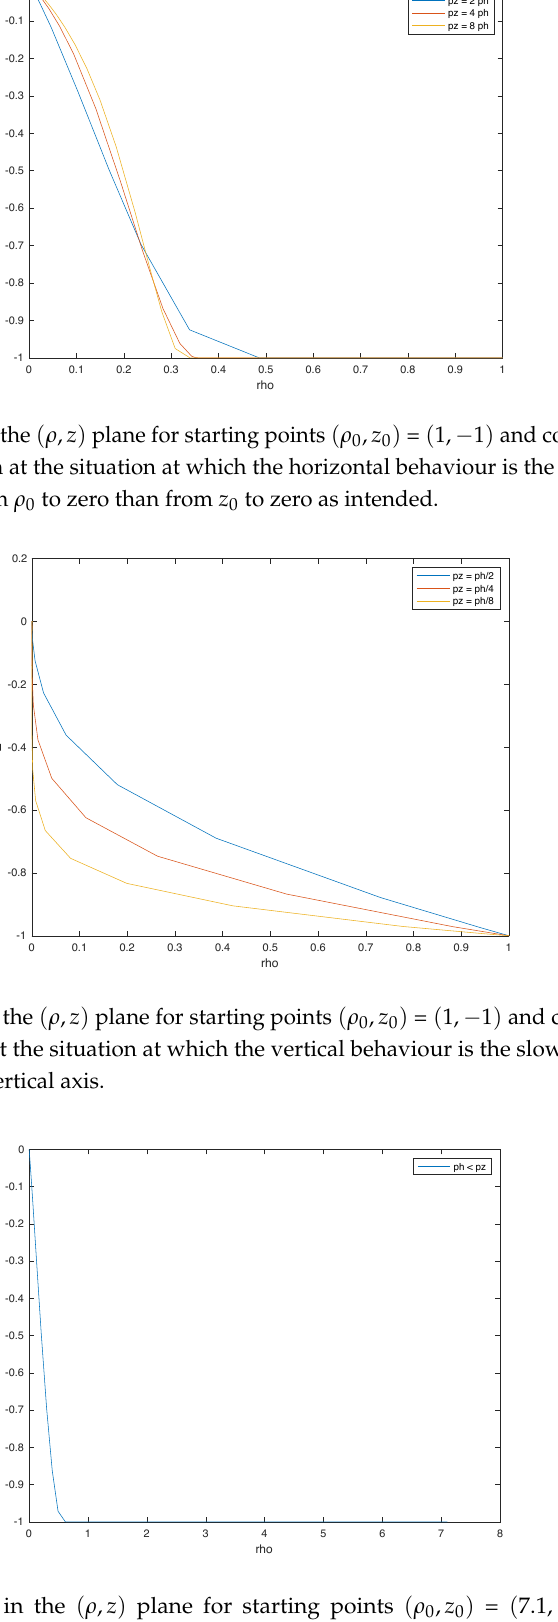
Figure 39. Trajectories in the ( ρ , z ) plane for starting points ( ρ 0 , z 0 ) = ( 7.1, − 1 ) and p z > ph . The trajectory illustrate the motion remains tangent to the vertical